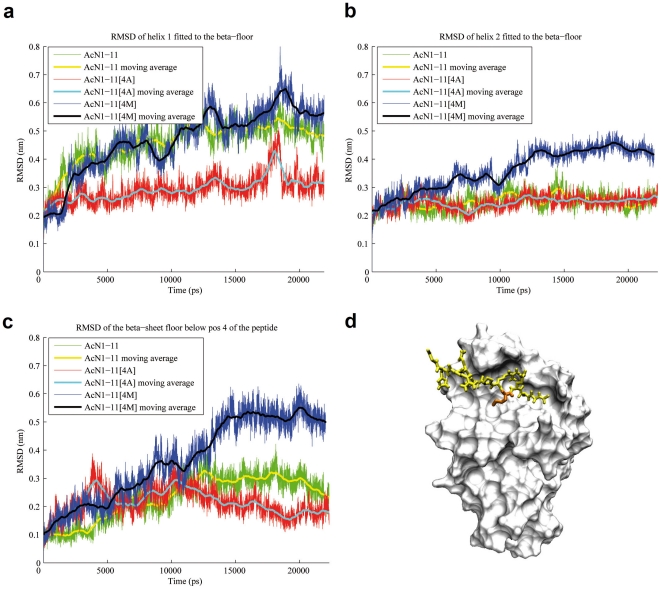
Structural rearrangements of the MHC.(a) Deformation of the α1-helix of the MHC. The average RMSD of AcN1-11 and AcN1-11[4M] are similar although the RMSD for AcN1-11 primarily results form deformation of residues 65 to 69, while AcN1-11[4M] deforms the whole helix. (b) Deformation of the α2-helix of the MHC. Only Ac1-11N[4M] affects the structure of the α2-helix. (c) Deformation of the ß-sheet floor below position 4 of the peptide. AcN1-11[4M] deforms the floor at a much higher level than the other two derivates. (d) 3D representation of the complex. The methionine side-chain stays in pocket 6 over the whole simulation time. The α1-helix is hidden to improve visualization of the binding groove. White: MHC. Yellow: peptide. Orange: Ac1-11[4M].